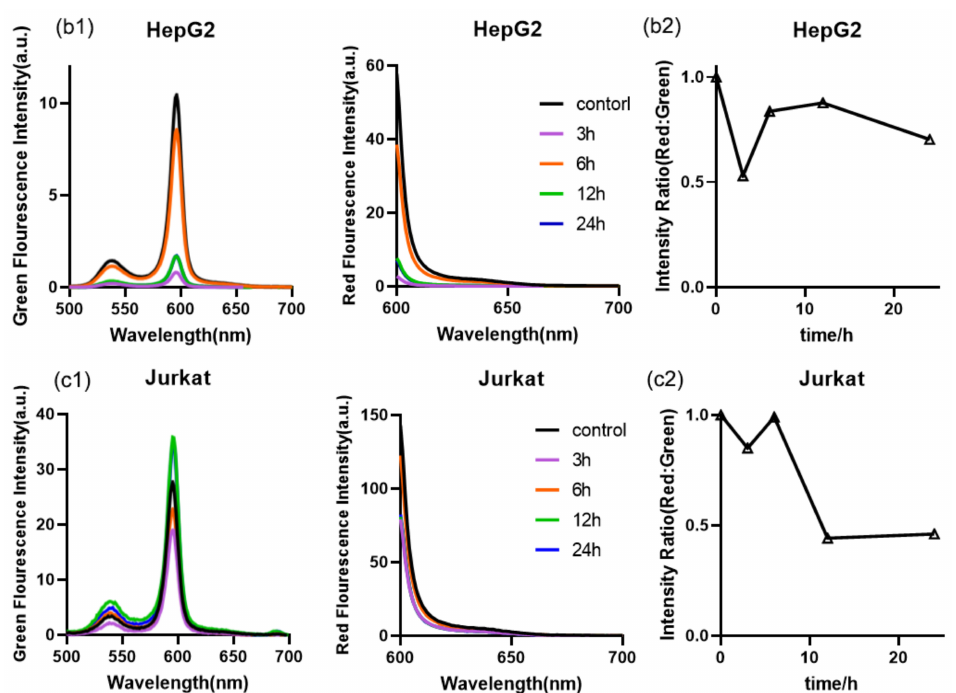
Figure 7. ( a1 – c1 , a2 – c2 ) MMP of the three Rg3-treated cell types, as determined using green and red fluorescence spectral measurements taken with the MMP assay kit and